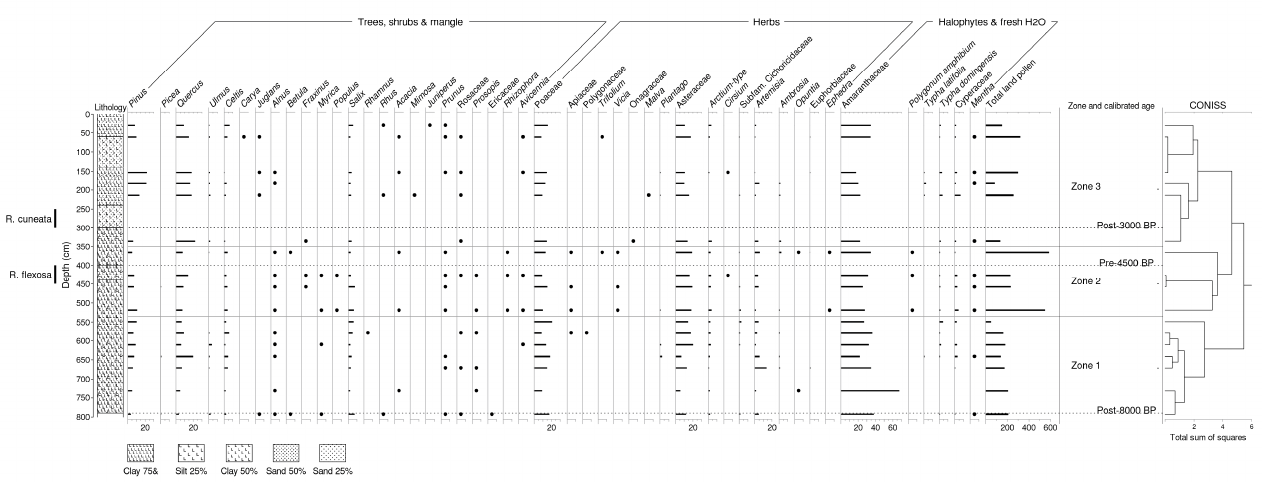
Figure 7. Nueces Bay (NB) relative pollen diagram (percentage of TLP) and Troels-Smith lithology. Note that the shellfish stratum with Rangia cuneata is unsampled due to the density of this shellfish bed.